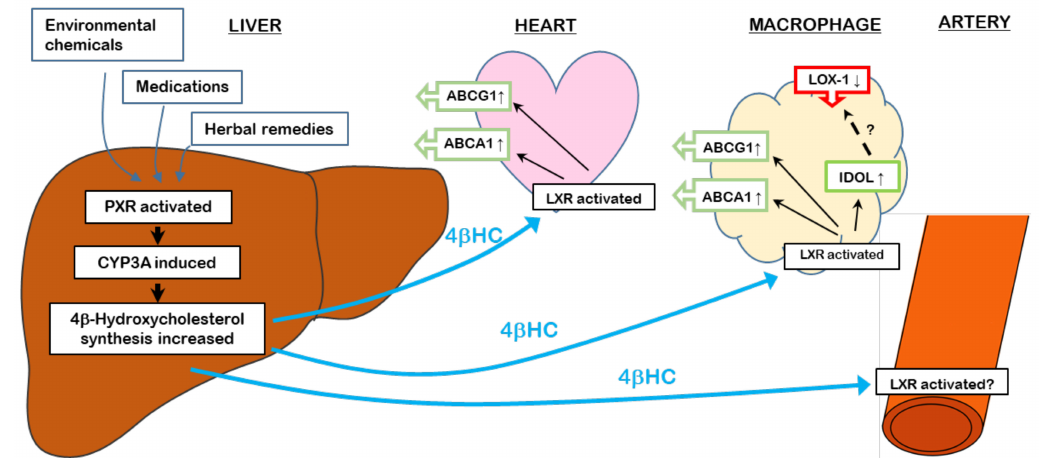
Figure 2. PXR–4 β -hydroxycholesterol–LXR pathway as a regulator of cholesterol transporters and its putative role in vascular tone regulation. PXR activation by xenobiotics elevates circulating 4 β